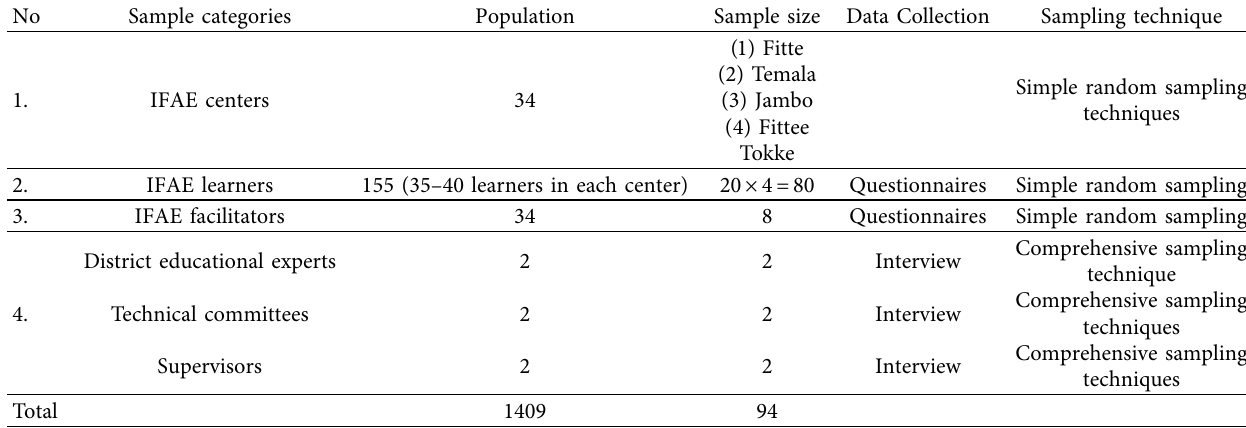
Table 1: Population, sample, and sampling technique.